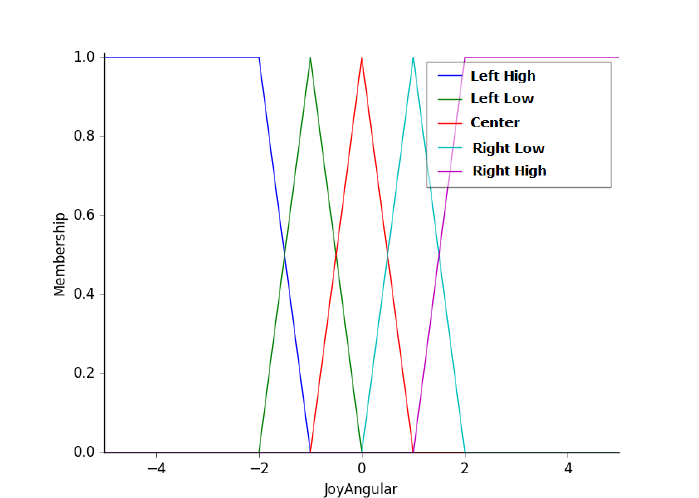
Figure 8. Membership functions of the variable